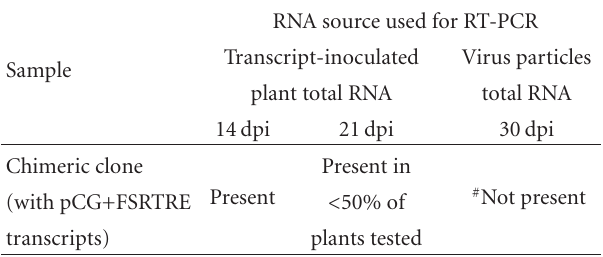
Table 3: Summary of sequence analyses carried out to confirm the presence of EB4 within the putative recombinant CGMMV. ( # A truncated EB4 sequence was detected at 30 dpi according to Figure 7 for pR P3U4 clone from nucleotide position 702 to